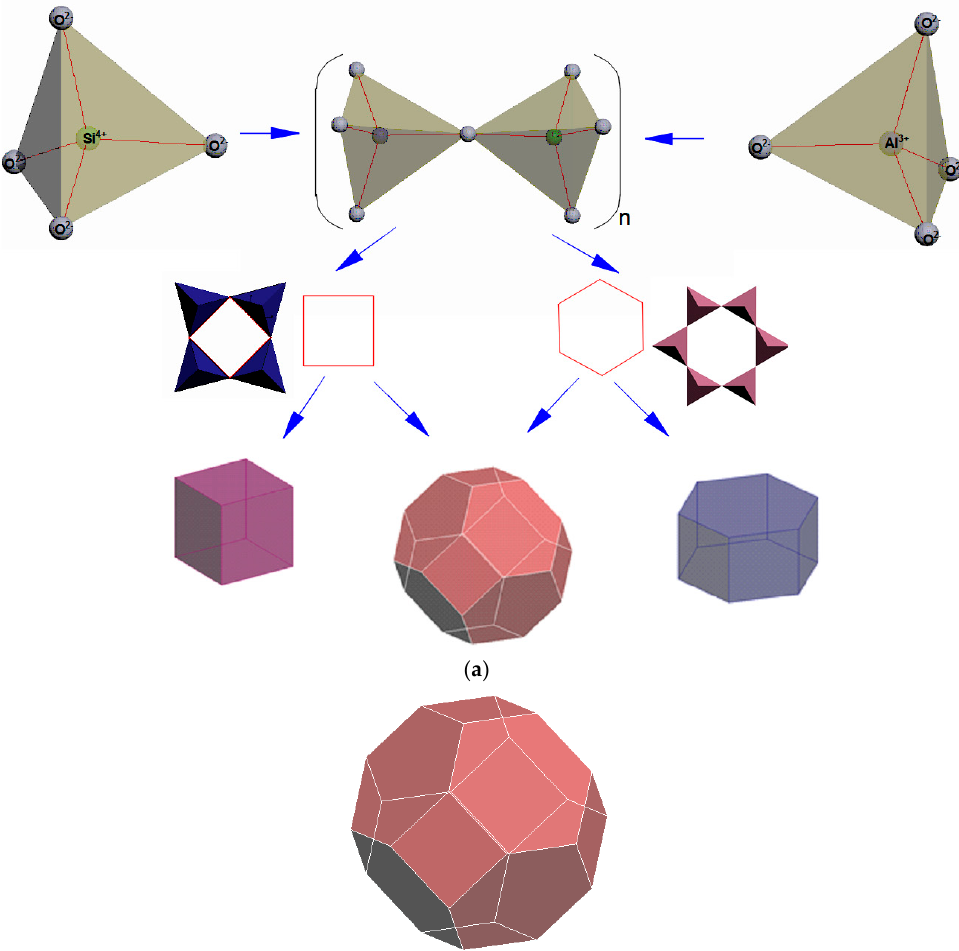
Figure 5. ( a ) Combination of four-membered and six-membered rings into a sodalite cage; ( b ) A polyhedron, i.e., a truncated octahedron, is the so-called sodalite cage ( β cage ( SOD )), formed by 24 tetrahedra (a tertiary building unit) [compiled by the authors].